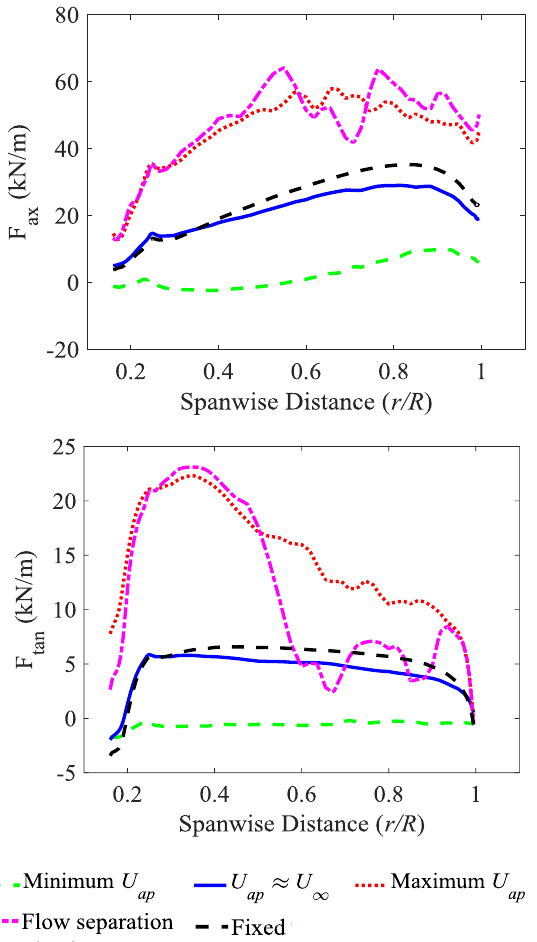
Fig. 19. Axial (top) and tangential (bottom) force profiles along the blade for fixed and surging turbine at minimum 𝑈 𝑎𝑝 , 𝑈 𝑎𝑝 ≈ 𝑈 ∞ , maximum 𝑈 𝑎𝑝 , and when the most flow separation occurs. All results are for the maximum surge frequency case ( 𝜔 ∗ =